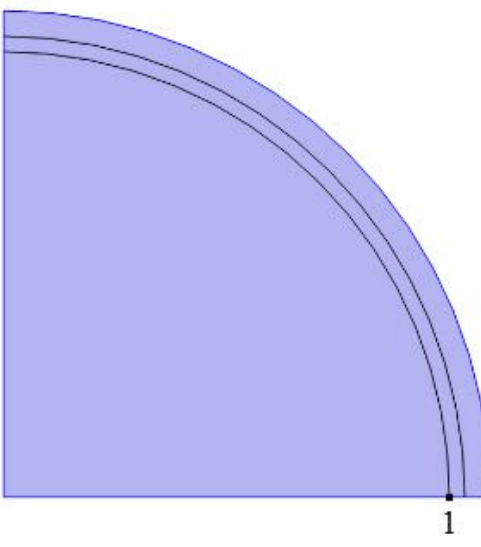
Figure 14. Location of the feature